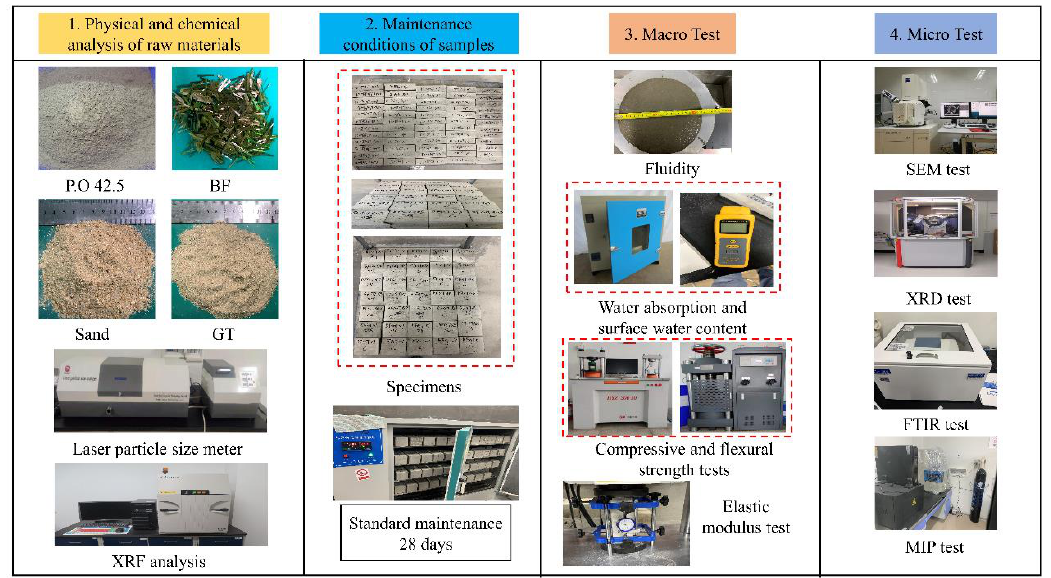
Figure 3. Flowchart of experimental methods.